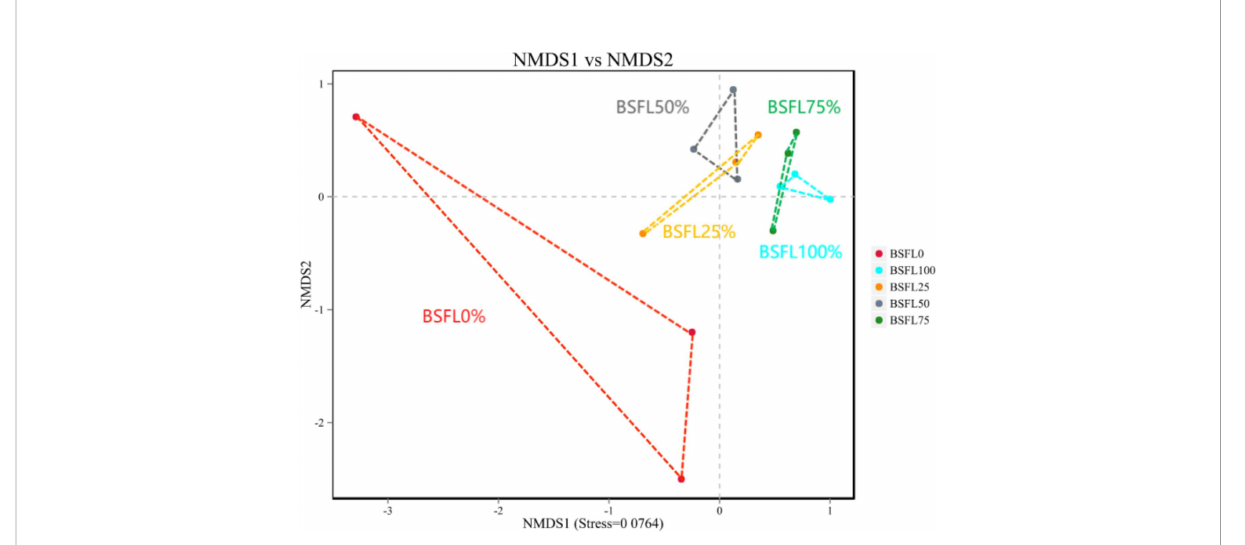
FIGURE 4 Non-MetricMulti-Dimensional Scaling (NMDS) of unweighted distances of intestinal microbiota associated to different